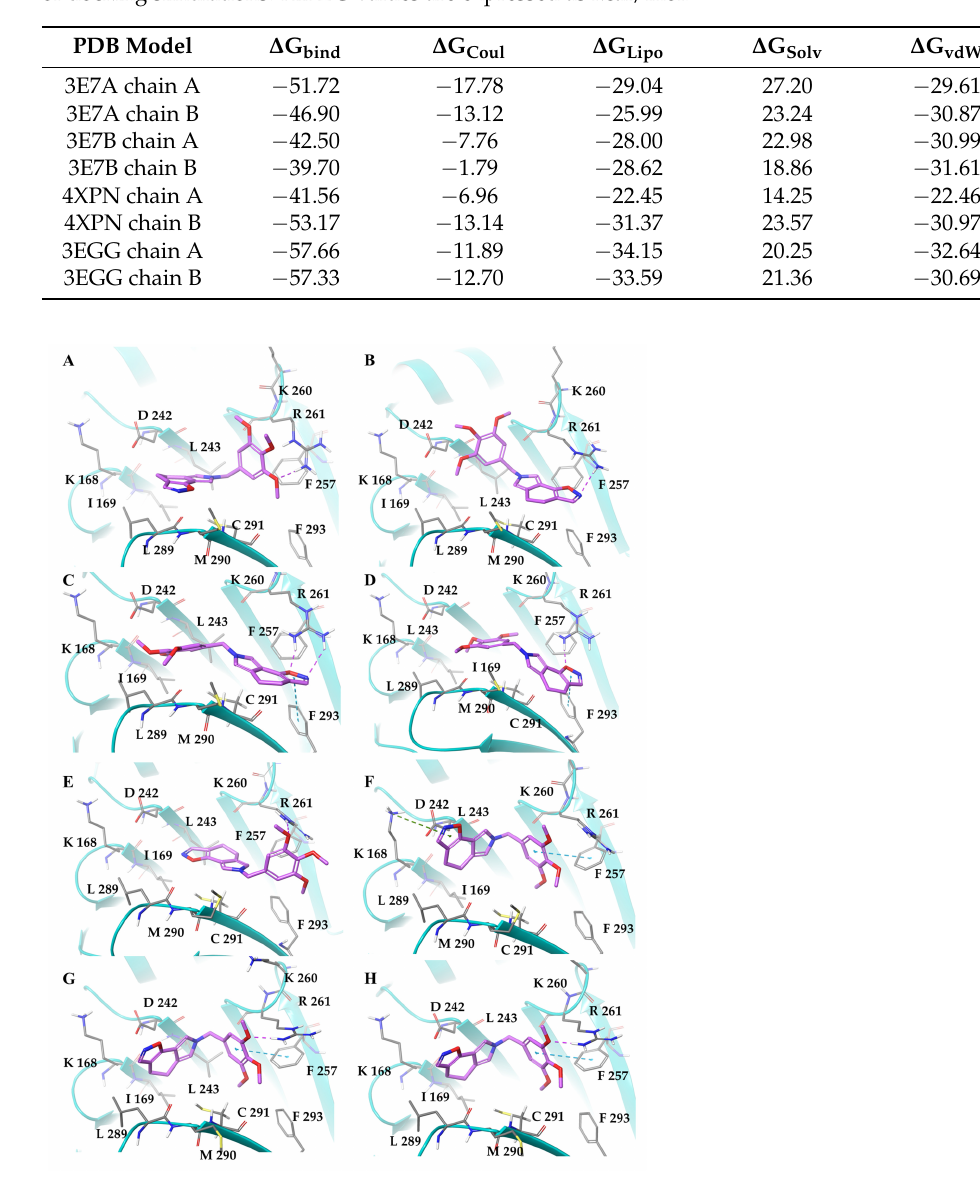
Figure 2. 3D representation of the best-docked poses of SIX2G with the RVxF domain. PDB models: ( A , B ) 3E7A, ( C , D ) 3E7B, ( E , F ) 4XPN and ( G , H ) 3EGG. For all the 3D structures, both chains A (subfigures A , C , E , G ) and B (subfigures B , D , F , H ) were considered and analyzed. PP1 is shown in teal cartoons, while the ligand and the most important residues, involved in the binding event, are shown as magenta and grey thick tube, respectively. In the 3D representation, H-bonds, π -cation and stacking interactions are indicated as dashed violet, green and cyan lines,